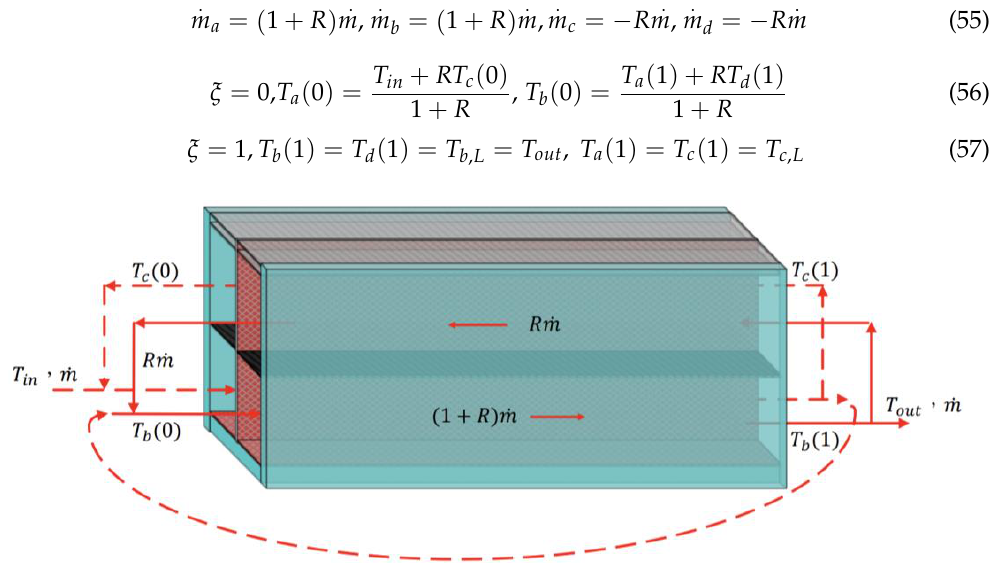
Figure 4. Schematic diagram of a recycling multi-pass solar air collector (Type A). Meanwhile, the collector thermal efficiencies η C , j ( j = A , B , C , D ) were calculated the actual useful energy gained by the air flow in and out four subchannels, incident solar radiation, and average absorber plate temperature, i.e.,